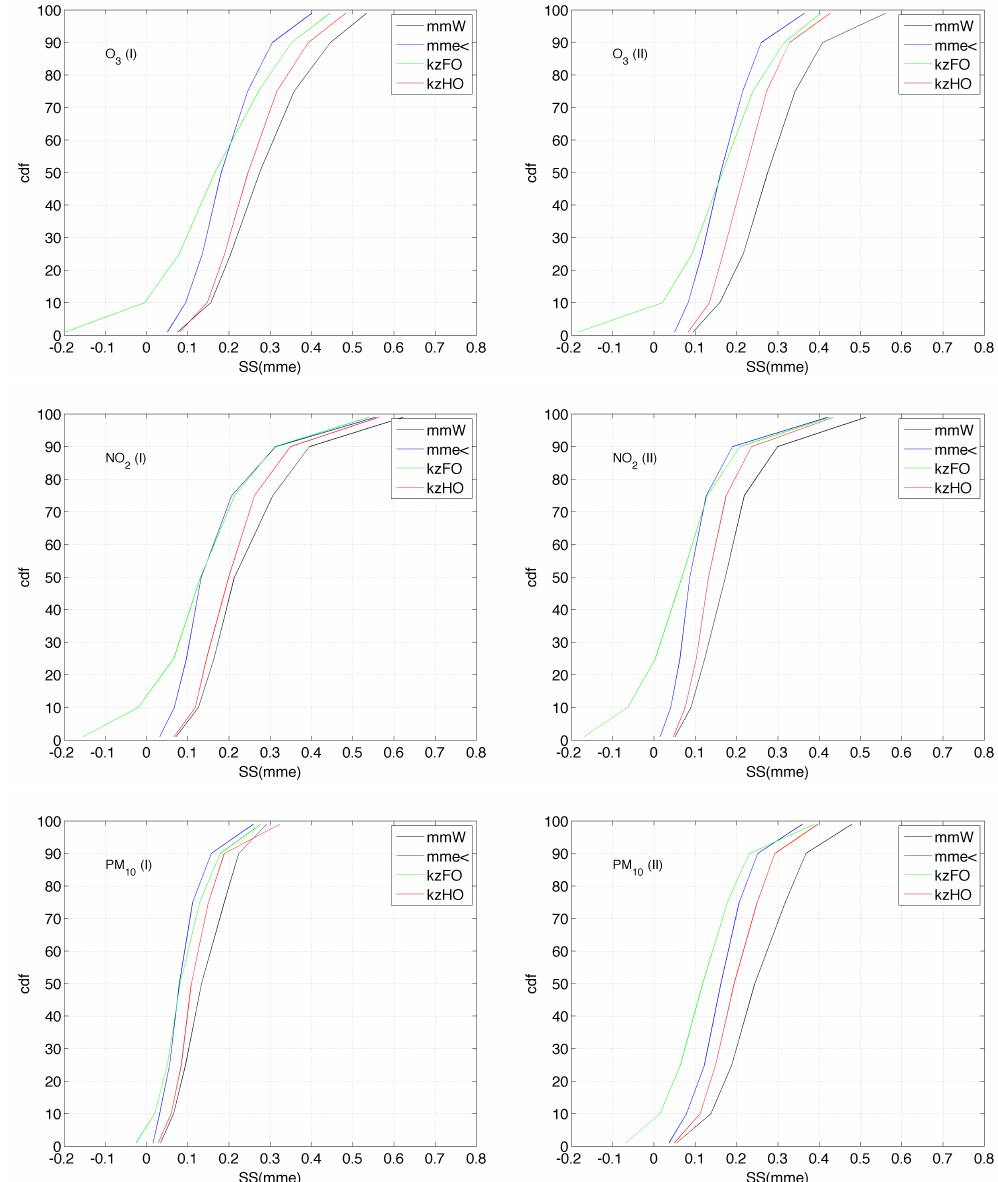
Figure 9. The cumulative density function of the skill score (1 − MSE X /MSE MME , X = mmW, mme < , kzFO, kzHO) over mme, evaluated at each monitoring site for the examined species of the two AQMEII